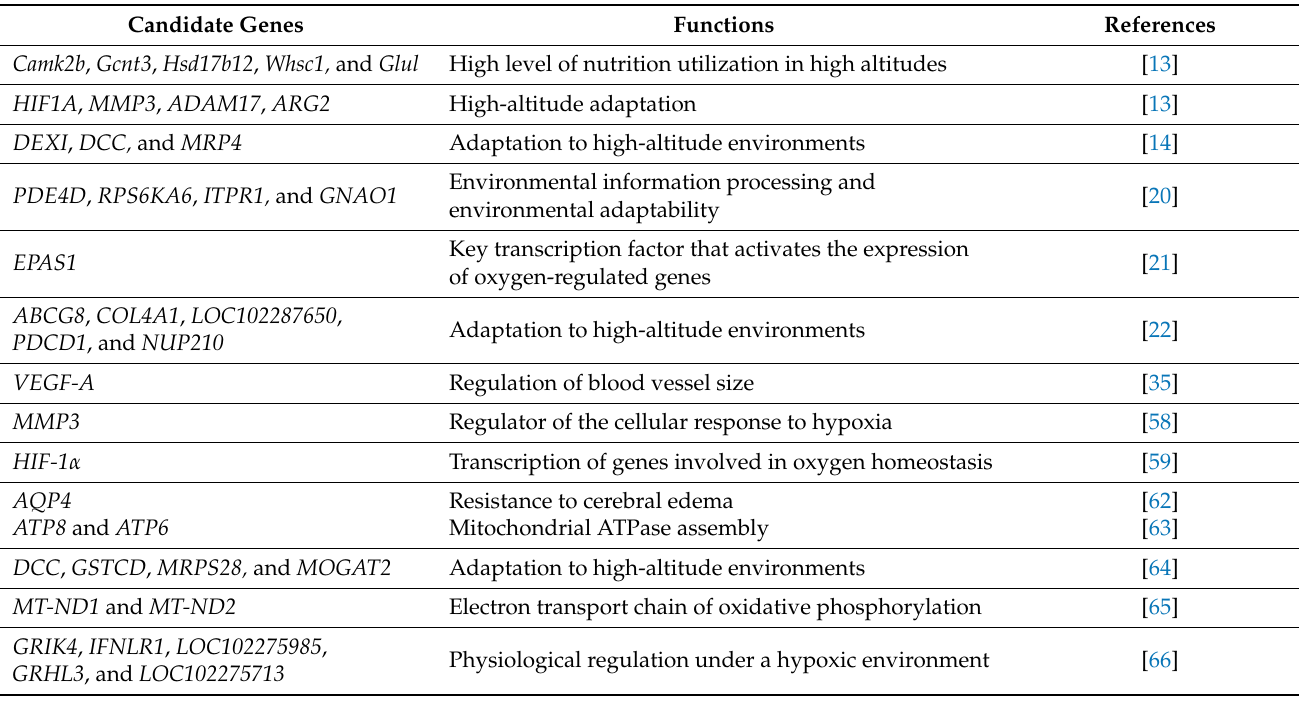
Table 2. Genes/candidate genes underlying selection signatures of yak adaptation to high altitudes. Candidate Genes